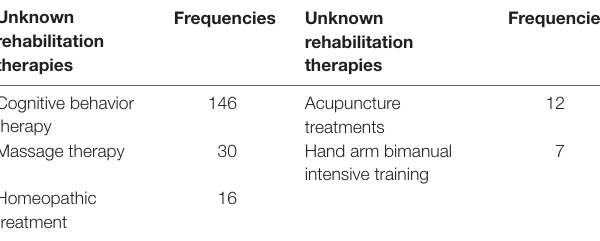
TABLE 3 | Potential repositioning rehabilitation therapies.